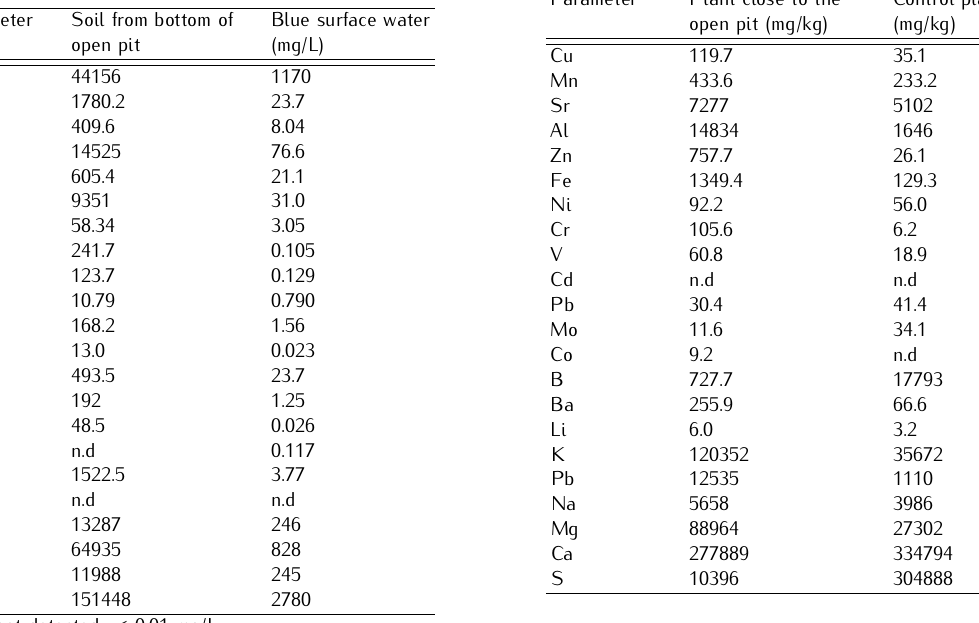
Table 4. Concentrations of heavy metals in crop plant.